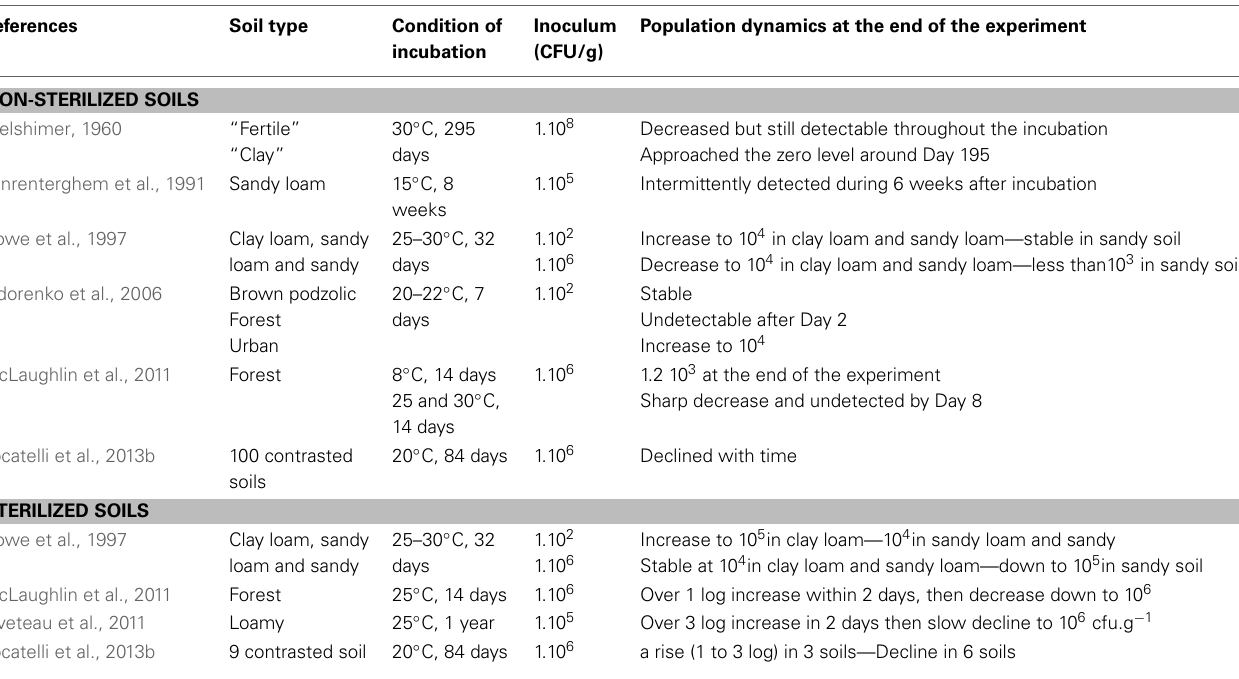
Table 2 | L. monocytogenes population dynamics after inoculation of soil